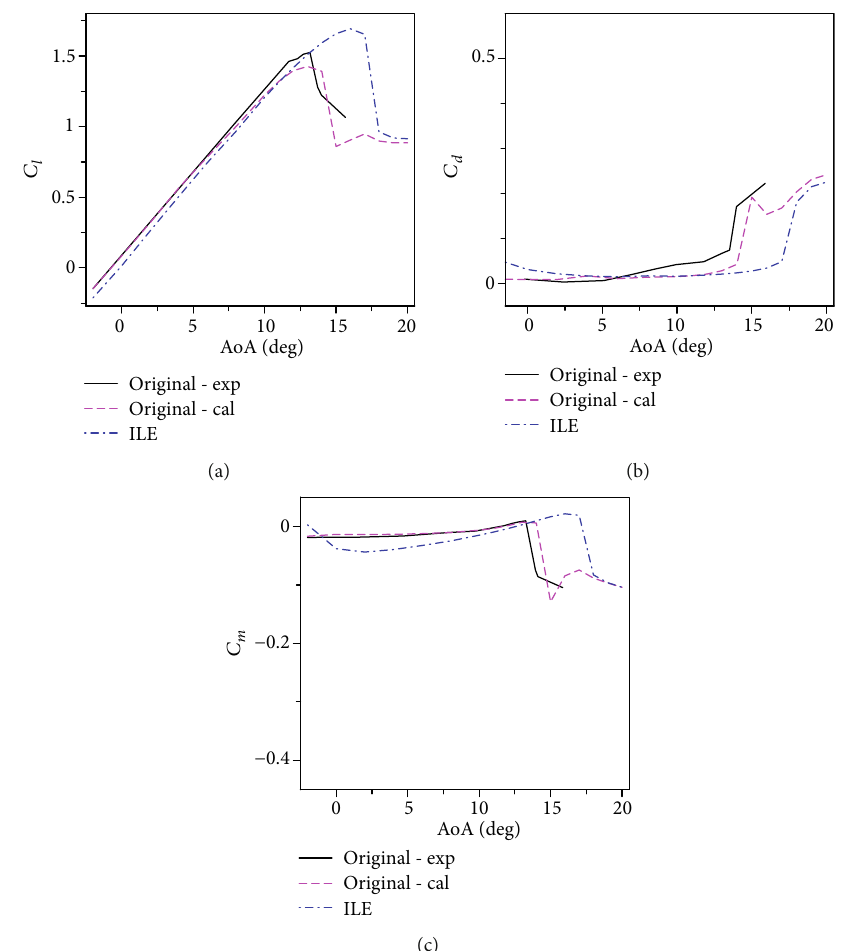
Figure 12: Comparison of aerodynamic coe ffi cients between the original airfoil and the ILE airfoil in Case 1: (a) lift coe ffi cients, (b) drag coe ffi cients, and (c) pitching moment coe ffi